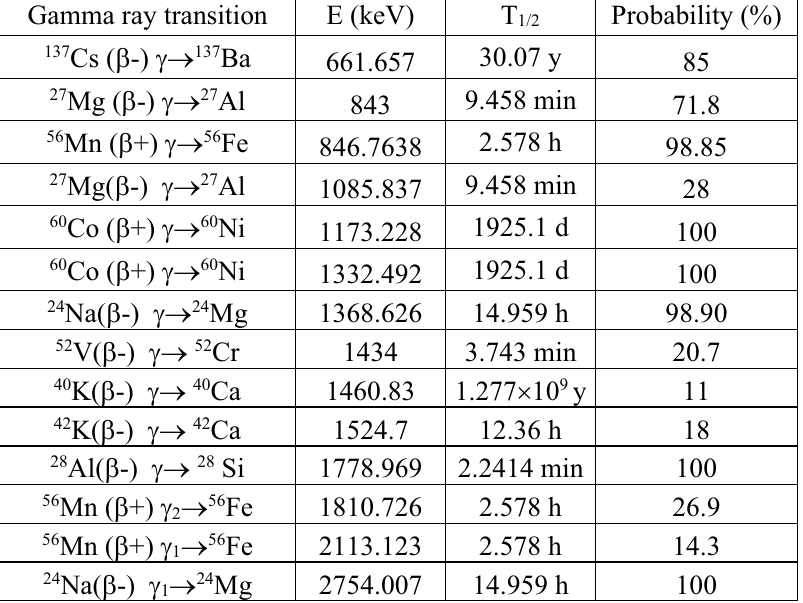
Table I. Radioactive decay energies, transition probabilities and half lives of gamma nuclides measured used in the neutron activation and detector calibration